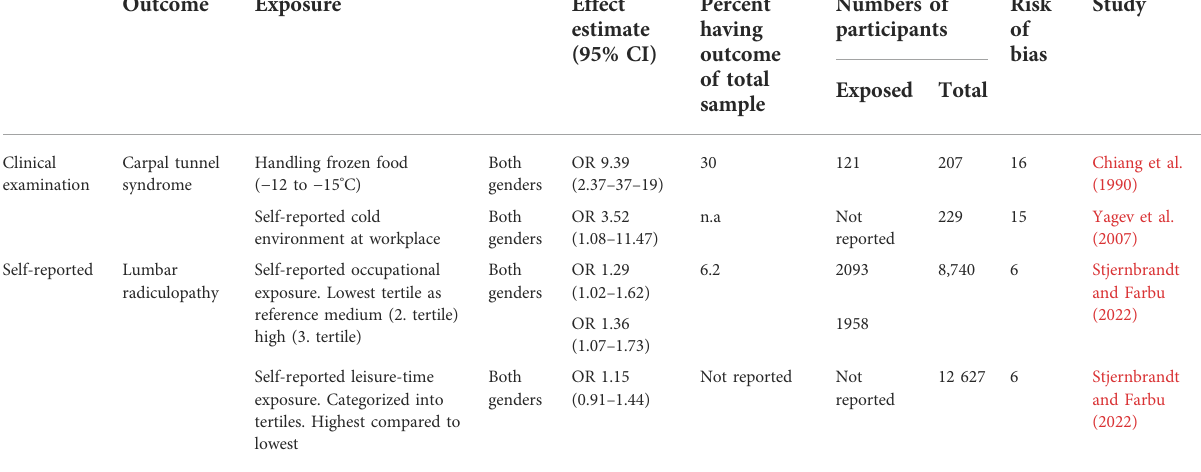
TABLE 2 Effect estimates sorted after type and type of assessment of neuropathic